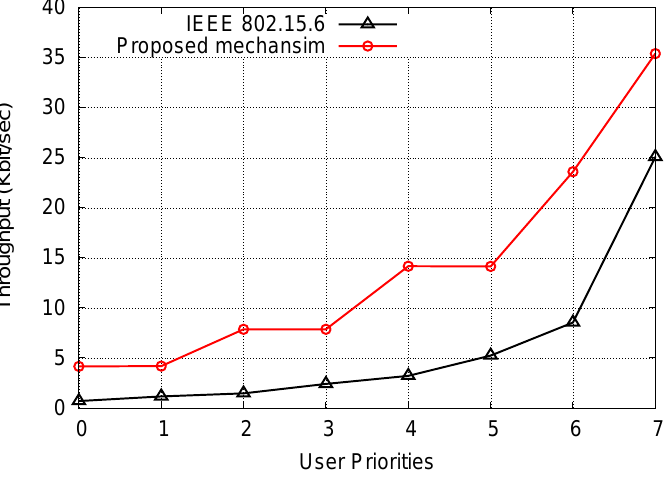
Figure 4. Throughput comparison of IEEE 802.15.6 and proposed mechanism for different UP (Scenario